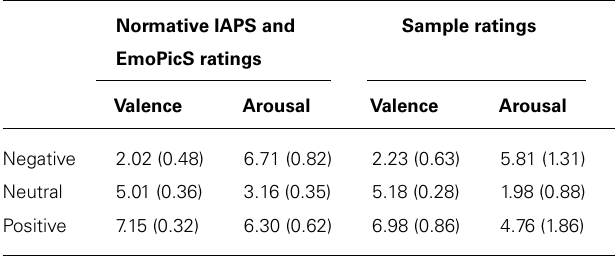
Table 1 | Mean valence and arousal ratings and standard deviations (in parentheses) forT2